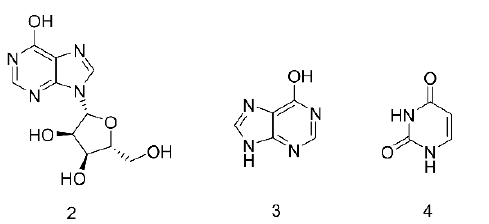
Figure 3. The structure of inosine ( 2 ), hypoxanthine ( 3 ), and uracil ( 4 ) [46].